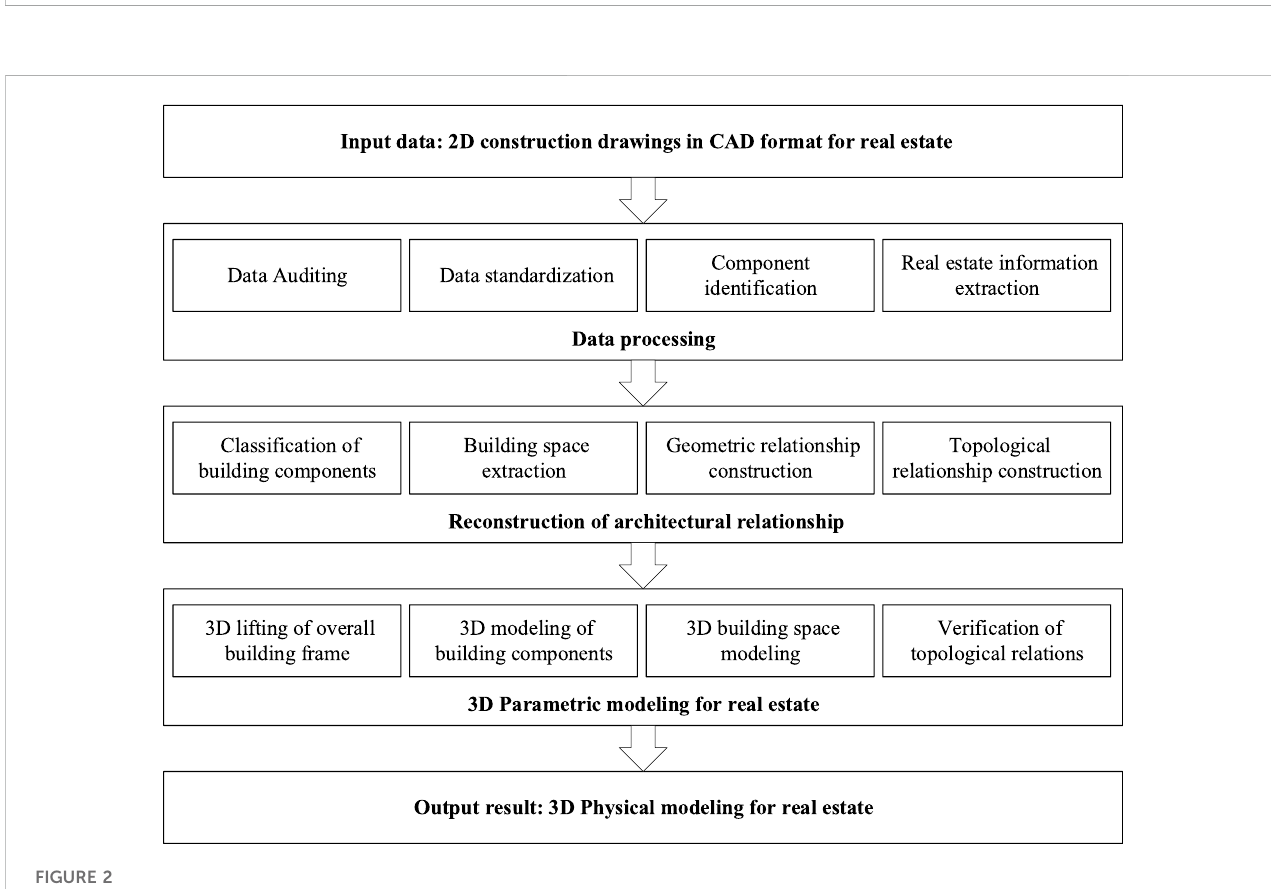
FIGURE 2 Method of landscape pattern optimization of the coastal city of this